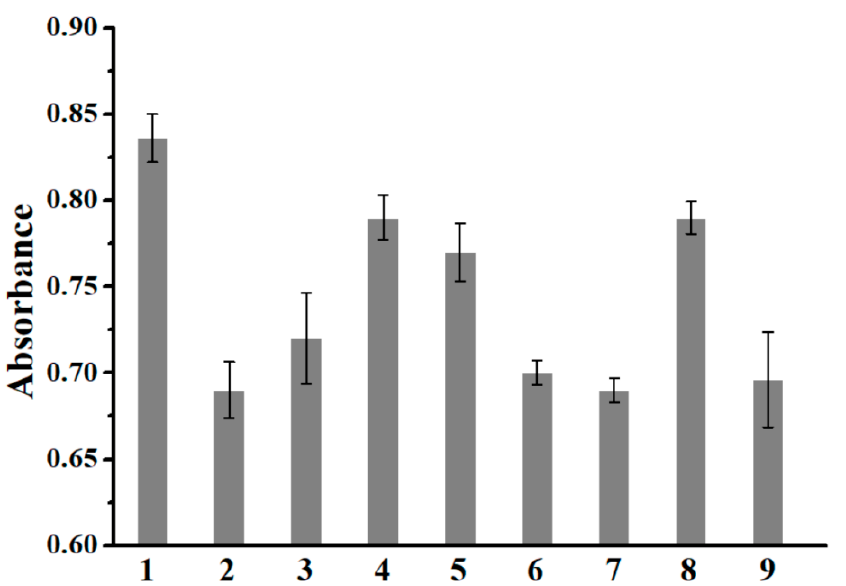
Figure 6. Absorption of colorimetric solutions (1), colorimetric solution containing VX (2), and colorimetric solution containing VX mixed with the 100 equiv. of interferents (parathion (3), DDVP (4), DCP (5), DMMP (6), toluene (7), AcOH (8), and Et 3 N (9)) at 644 nm.